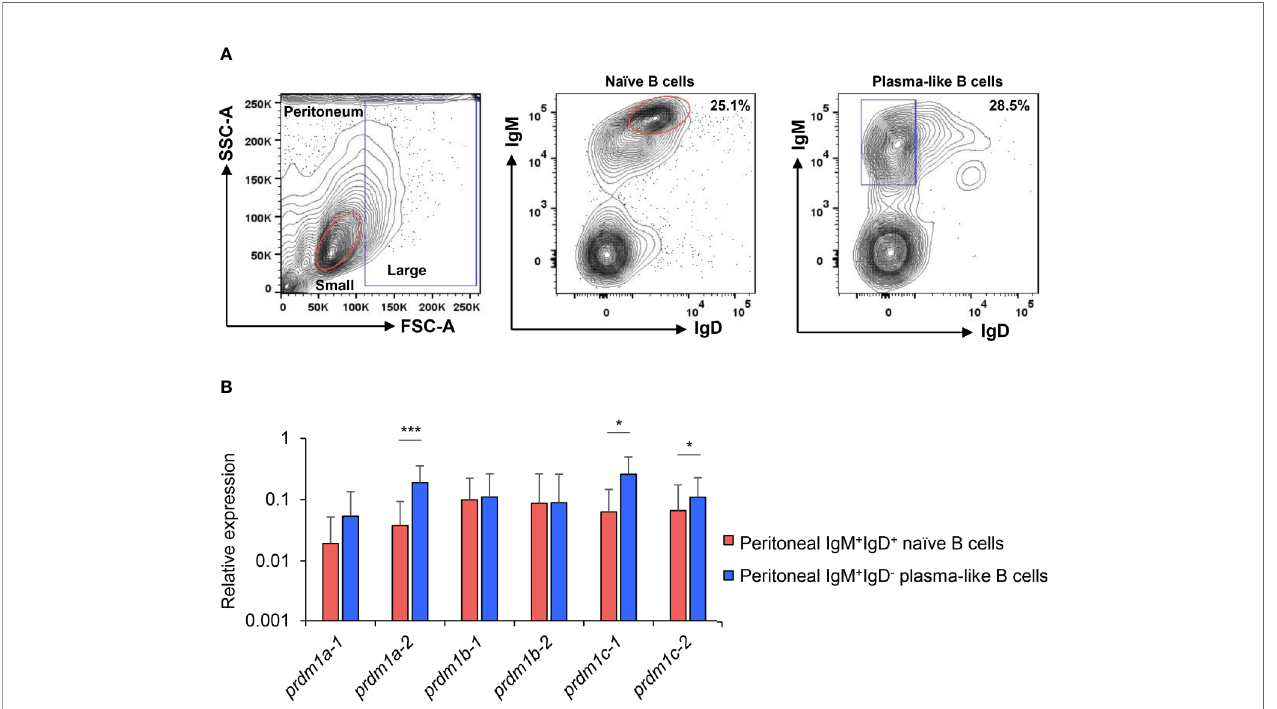
FIGURE 8 | Expression analysis of O. mykiss prdm1 genes in isolated B cell subsets from the peritoneum. Levels of transcription of all rainbow trout prdm1 genes in different B-cell subsets from the peritoneum, including IgM + IgD + naive B cells from lymphoid gate and IgM + IgD − plasma-like cells from the myeloid gate (A) Representative plots showing sorted populations. Gene expression data were normalized against the endogenous control ef-1 a and are shown as relative expression levels (means + SD; n = 10). (B) Asterisks indicate signi fi cant differences between transcription levels in the two B cell populations (* p < 0.05 and *** p <